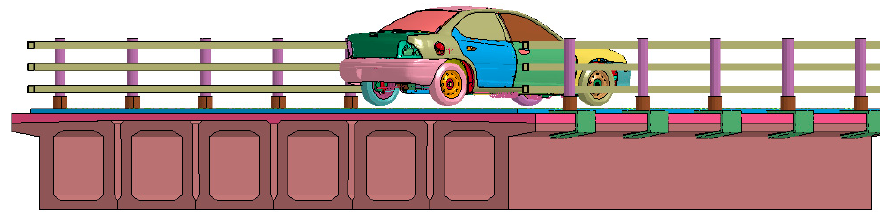
Figure 4. Car and bridge finite element 3D model.